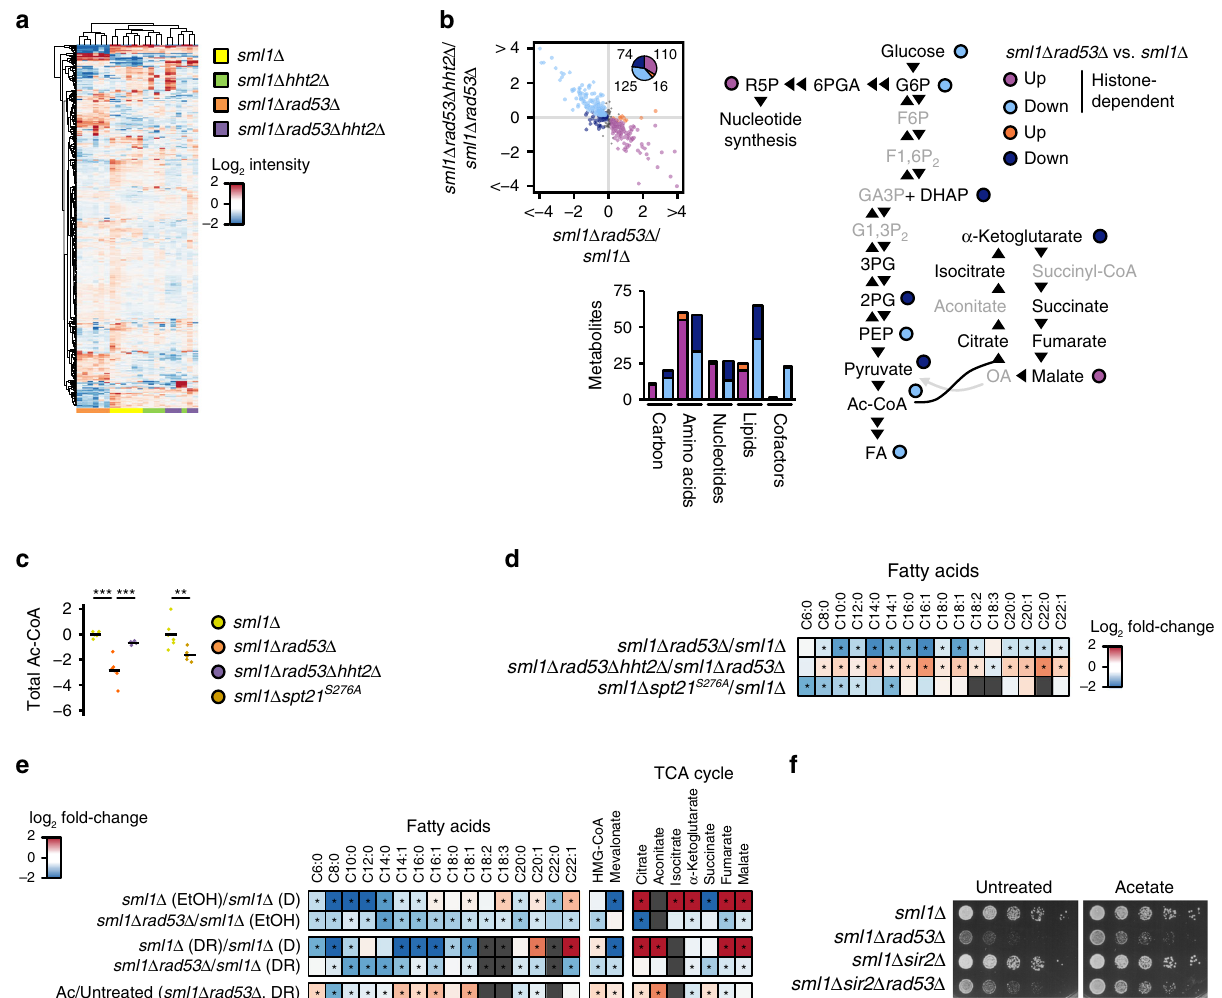
Fig. 6 Histone hyper-acetylation affects central carbon metabolism. a Global metabolome analysis of cells of the indicated genotypes cultured in synthetic complete medium with normal glucose. Replicates were clustered by centered log2 metabolite intensities ( n = 5 – 6 independent replicate cultures). b Classi fi cation of altered metabolites in sml1 Δ rad53 Δ vs sml1 Δ cells by HHT2 dependence and super-pathway. Alterations in glycolysis and TCA cycle are depicted. Signi fi cances were calculated by SAM (FDR < 0.1). c Jitter plots of total Ac-CoA levels from metabolomics data. The indicated genotypes are normalized by the average of the internal sml1 Δ control strain. The mean values are represented by black bars. Signi fi cances were calculated by Kruskal – Wallis rank sum test ( p sml1 Δ rad53 Δ hht2 Δ _ sml1 Δ rad53 Δ _ sml1 Δ = 0.0041), followed by Mann – Whitney test (two-sided) with Benjamini – Hochberg correction ( p sml1 Δ rad53 Δ _vs_ sml1 Δ = 0.0043, p sml1 Δ rad53 Δ hht2 Δ _vs_ sml1 Δ rad53 Δ = 0.0043), or by Mann – Whitney test ( p sml1 Δ spt21S276A _vs_ sml1 Δ = 0.0022). n = 5 ( sml1 Δ rad53 Δ hht2 Δ ) or 6 (other genotypes) independent culture replicates. d Heat map representing fatty-acid alterations from metabolomics data in cells with the indicated experimental vs control genotypes. Asterisks indicate signi fi cant alterations by SAM analysis (FDR < 0.1, q values are listed in Supplementary Table 4). e Heat map representing fatty-acid sterol synthesis and TCA cycle intermediate alterations from metabolomics data in cells with the indicated experimental vs control genotypes or conditions. Asterisks indicate signi fi cant alterations by SAM analysis (FDR < 0.1, q values are listed in Supplementary Table 5). f 10 7 cells/mL were serially diluted (1:6), spotted on YP plates with 0.01% glucose, with or without acetate, and grown for 2d. D glucose, DR glucose restriction (0.04% in liquid media), EtOH ethanol; Aux Auxin; tc tetracycline; Ac-CoA acetyl-coenzyme A; G6P glucose 6-phosphate;